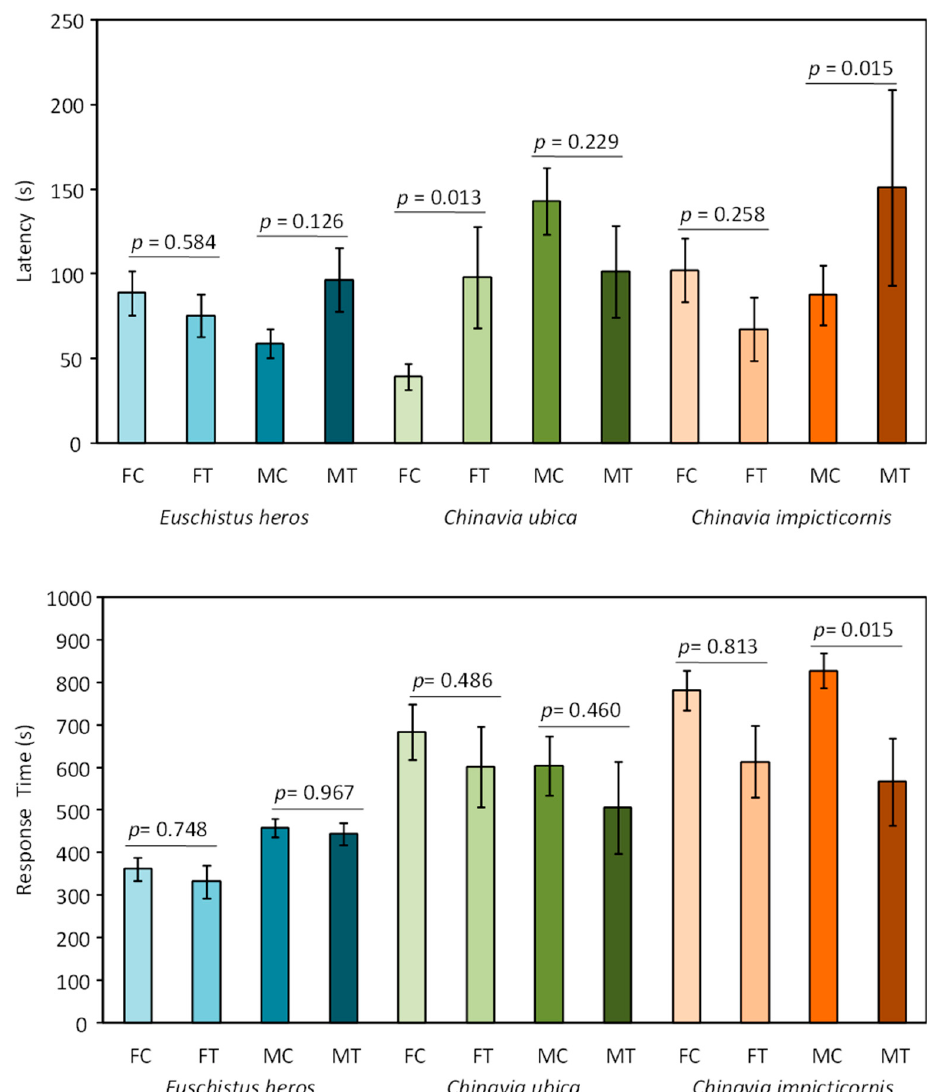
Figure 2. Effect of conspecific female rival signals on latency and response time of males and females of three stink bug species. Latency (s) (upper graph) and Response Time (s) (lower graph) of Euschistus heros , Chinavia ubica and Chinavia impicticornis females (F) and males (M) placed on control (non-vibrated—C) or treatment (vibrated with conspecific female rival signals—T) plants. Significant differences between times in C and T were established with generalized linear mixed models (GLLM). N = Latency Euschistus heros FC = 24, FT = 20, MC = 26, MT = 23, Chinavia ubica FC =14, FT = 10, MC = 17, MT = 11, Chinavia impicticornis FC = 23, FT = 11, MC = 22, MT = 9. Response time Euschistus heros FC = 29, FT = 24, MC = 27, MT = 21, Chinavia ubica FC =19, FT = 12, MC = 19, MT = 12, Chinavia impicticornis FC = 23, FT = 9, MC = 20, MT = 11.